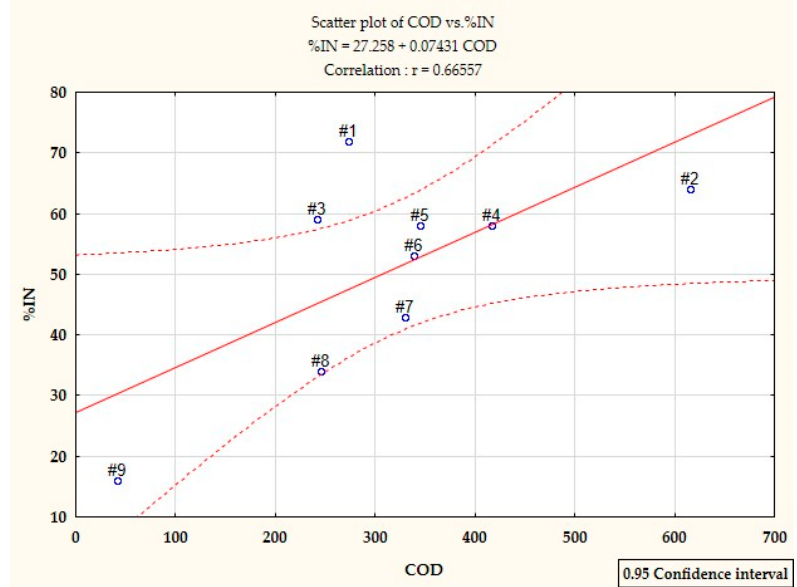
Figure 5. Scatter plot showing the strength of the correlation between% IN and COD of the ana- lysed wastewater: #1 styrene butadiene rubbers; #2 solvents: butyl acetate, ethyl acetate; #3 styrene; #4 acrylonitrile rubbers; #5 terpenes; #6 emulsifiers; #7 polyvinyl acetate; #8 polyvinyl chloride; #9 methacrylate.